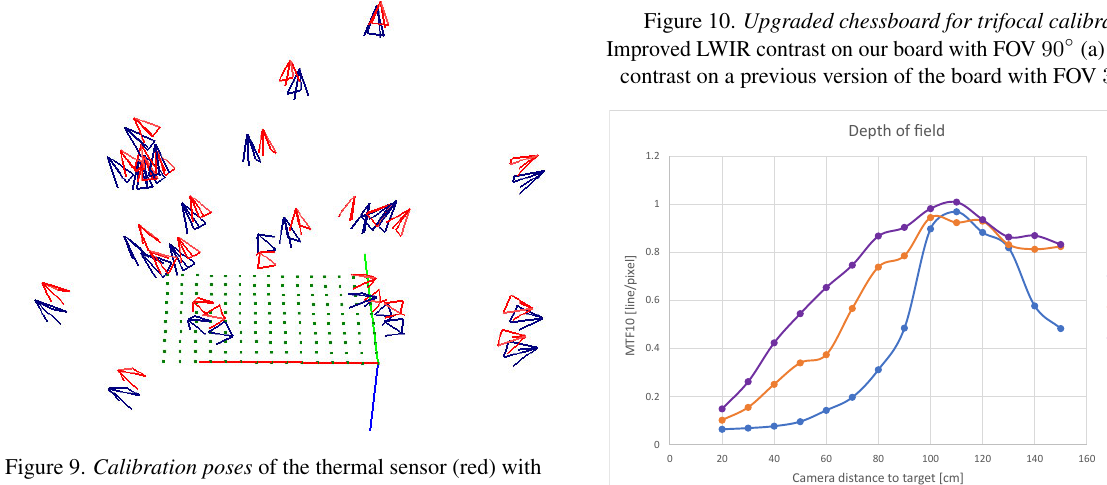
Figure 9. Calibration poses of the thermal sensor (red) with respect to the left stereo camera (blue). Figure 11. Depth of field as MTF10 in relation to target distance. while simultaneously having a larger focal length and therefore better nominal spatial resolution. To verify which lens system